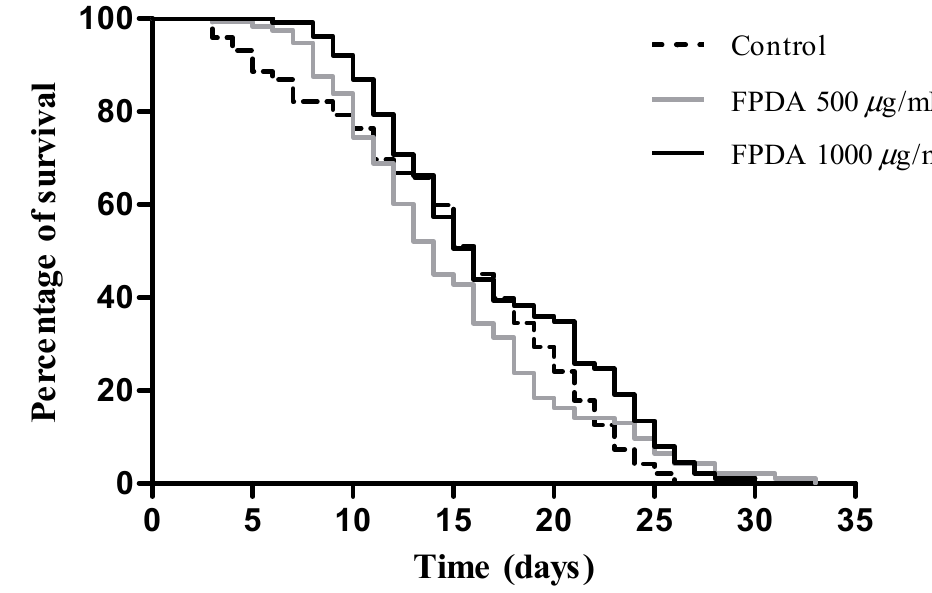
Figure 6. Lifespan assay in the in vivo experimental model of C. elegans subjected to treatment with FPDA. * Statistically significant results ( p < 0.05) when the treated group was compared with the control group.